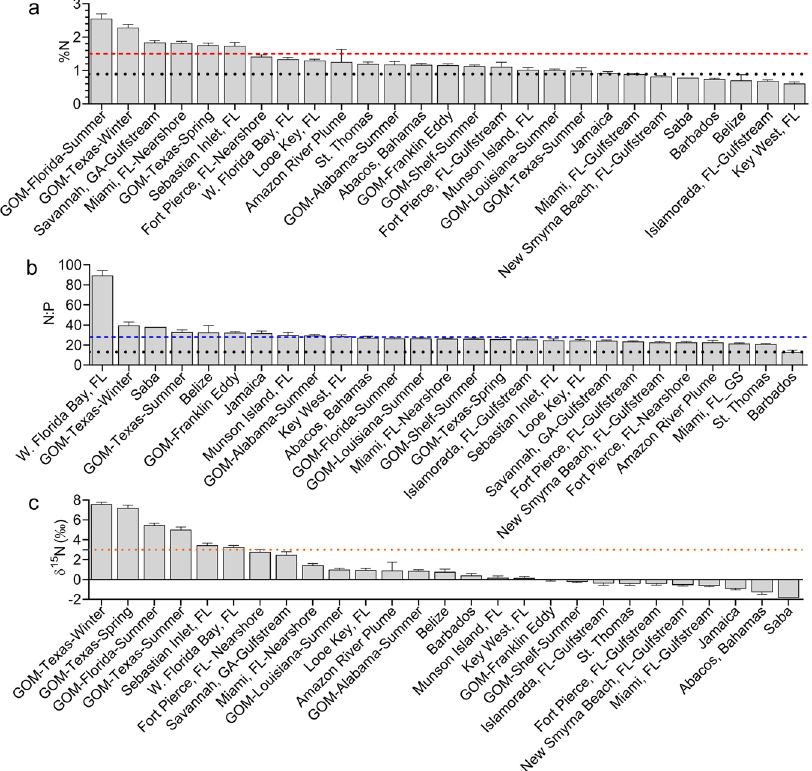
Fig. 3 Post-2010 Sargassum tissue nutrient contents by location. Post-2010 Sargassum tissue nutrient contents by location (mean ± SE), as well as Northern Hemisphere meteorological season for Gulf of Mexico (GOM) samples, indicating where %N and N:P ratios were greater than the 1980s baseline mean for the entire dataset (black dotted lines). a For %N, values have signi fi cantly increased from the 1980s (decadal mean = 0.89%) to post-2010 (decadal mean = 1.21%); %N values >1.5 (red dashed line) are considered non-limiting to macroalgal growth 43 . b N:P ratios have signi fi cantly (111%; ANOVA, F = 1 93.4, P < 0.001) increased from the 1980s (decadal mean = 13.2) to post-2010 (decadal mean = 27.8, blue dashed line). c Enriched δ 15 N values (> + 3 ‰ , orange dotted line) are indicative of urbanized wastewater discharges, while more depleted values are indicative of N 2 fi xation, atmospheric deposition, and